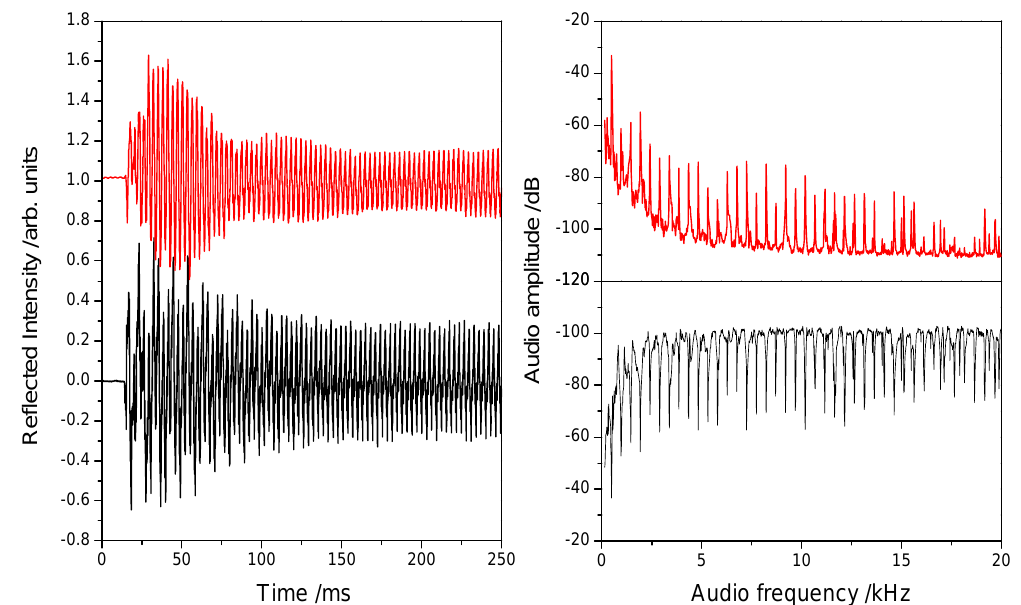
Figure 18. Left: Response of the FBG transducer (top) and the PZT to a plucked E4 string. Right: The Fourier transform of the respective complete waveforms shows the fundamental frequency at 326.8 Hz and overtones up to 12